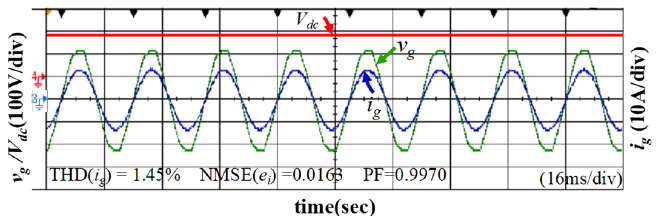
Figure 10. Experimental results of grid-connected inverter with DC-bus voltage ( V dc = 180 V).